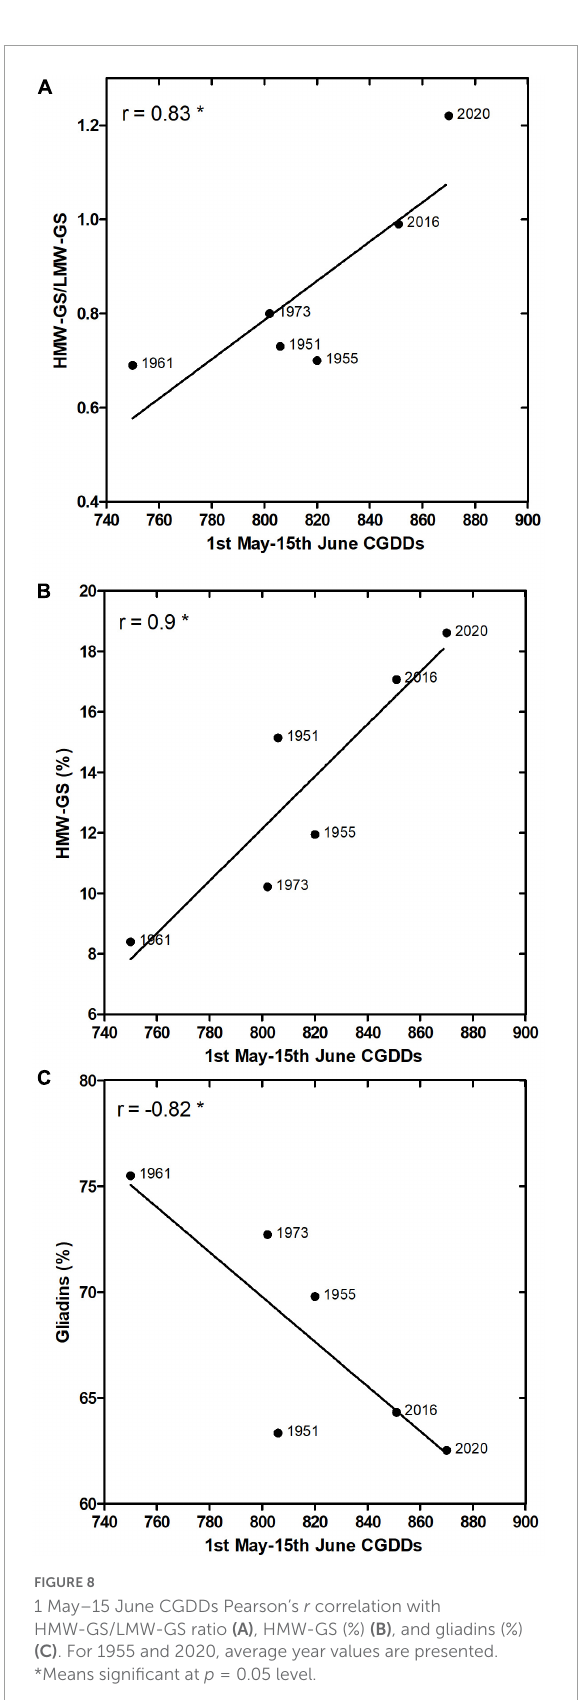
FIGURE8 1 May–15 June CGDDs Pearson’s r correlation with HMW-GS/LMW-GS ratio (A) , HMW-GS (%) (B) , and gliadins (%) (C) . For 1955 and 2020, average year values are presented. *Means significant at p = 0.05